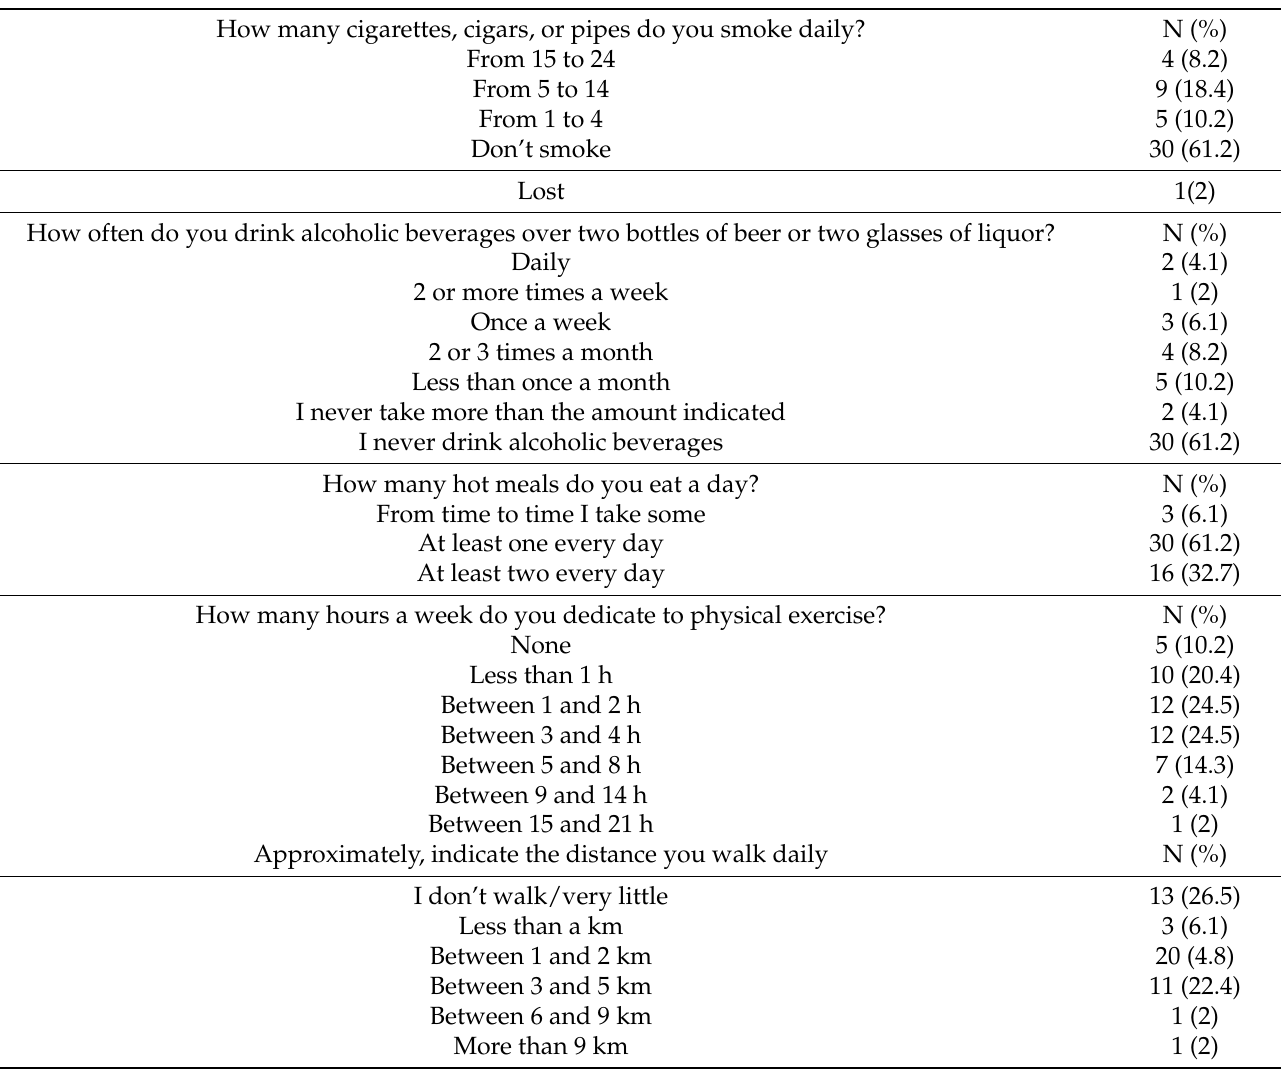
Table 4. Characteristics of lifestyle